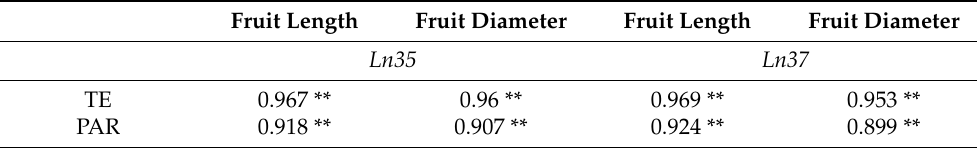
Table 2. The correlation analysis between fruit shape and TE and PAR. Fruit Length Fruit Diameter Fruit Length Fruit Diameter Ln35 Ln37 TE 0.967 ** 0.96 ** 0.969 ** 0.953 ** PAR 0.918 ** 0.907 ** 0.924 ** 0.899